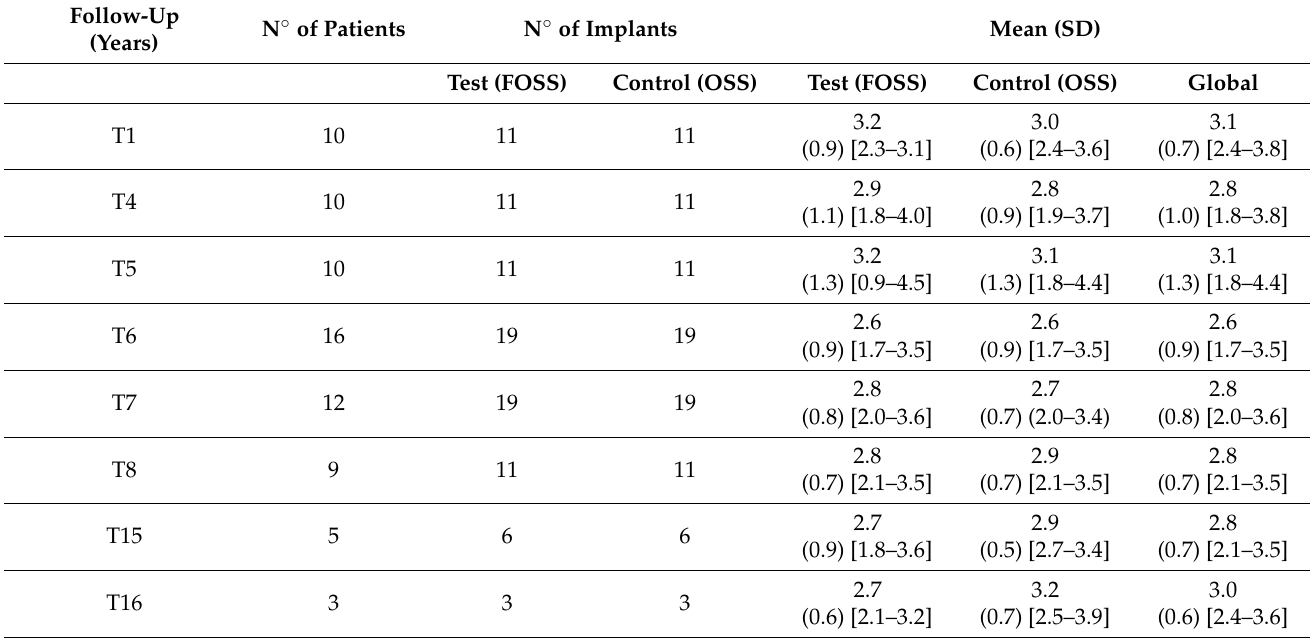
Figure 3. Interproximal bone level change (BLC, mm) over time for implant type; y = years. Table 3. Values of PD (mm) over time for control (OSS) and test (FOSS) implants.